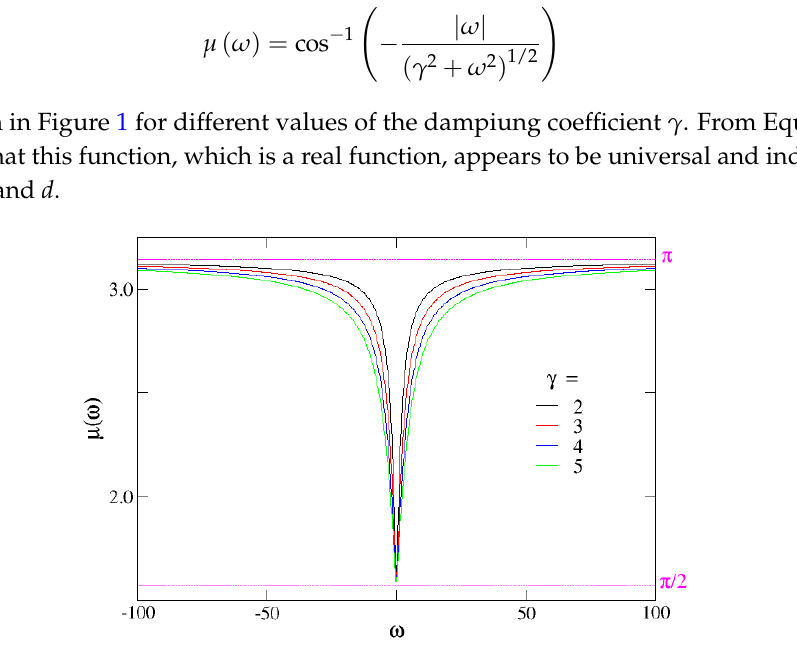
Figure 1. µ ( ω ) . The function defined in (30) for several value of the damping constant γ . Notice as this function is universal, i.e., is independent of the fractional exponent z and of the dimension of the substrate d . Notice the limit in the short and long time limit, π and π 2